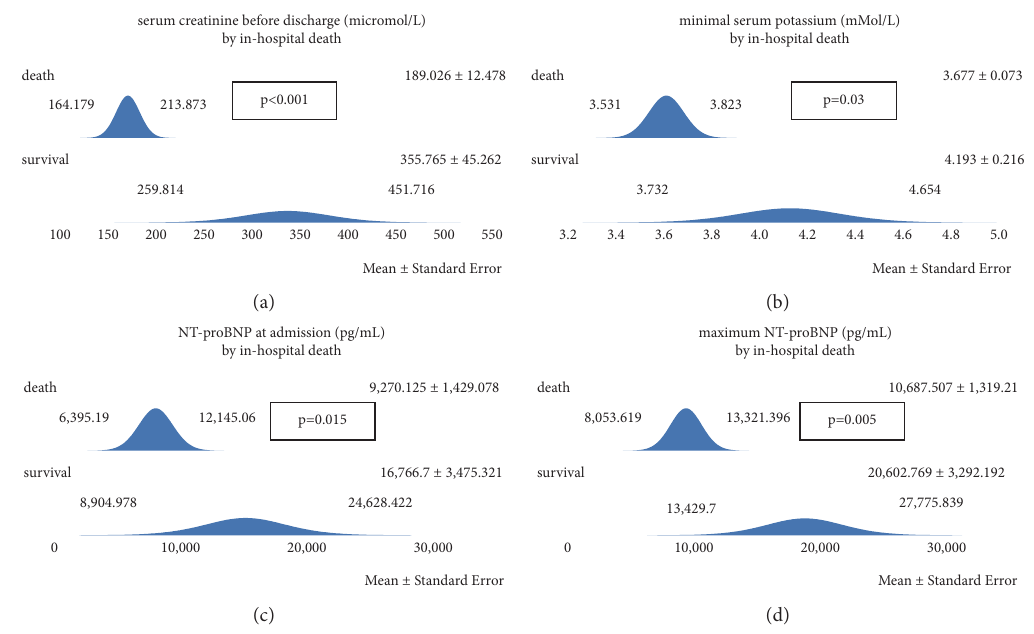
Figure 1: Regarding the outcome parameter ‘survival,’ four variables were significantly different between surviving and nonsurviving subjects. (a) The last serum creatinine concentration measured, either before death or discharge from the hospital, was higher in survivors. (b) The minimal serum potassium level during the stay at the hospital was higher in survivors. (c), (d) Both the initial and the maximum NT-proBNP were also higher in surviving patients (data are represented as mean+/ −